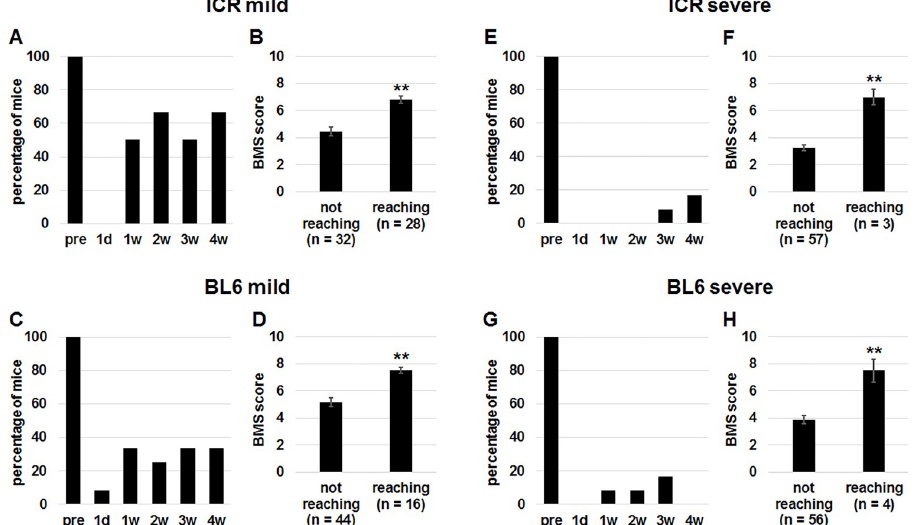
Fig 3. Comparison of BMS scores between mice which did not reach the goal and those which did after SCI. (A, C, E, G) Percentages of ICR (A, E) and C57BL/6 (C, G) mice before (pre) and 1 day (d), and 1, 2, 3 and 4 weeks (w) after mild (A, C) and severe (E, G) SCI which reached the goal during the test. (B, D, F, H) ICR (B, F) and C57BL/6 (D, H) mice 1 day, and 1, 2, 3 and 4 weeks after mild (B, D) and severe (F, H) SCI were divided into those which did not reach the goal and those which did. BMS scores of the 2 groups were compared. Mann-Whitney U test, �� p < 0.01.